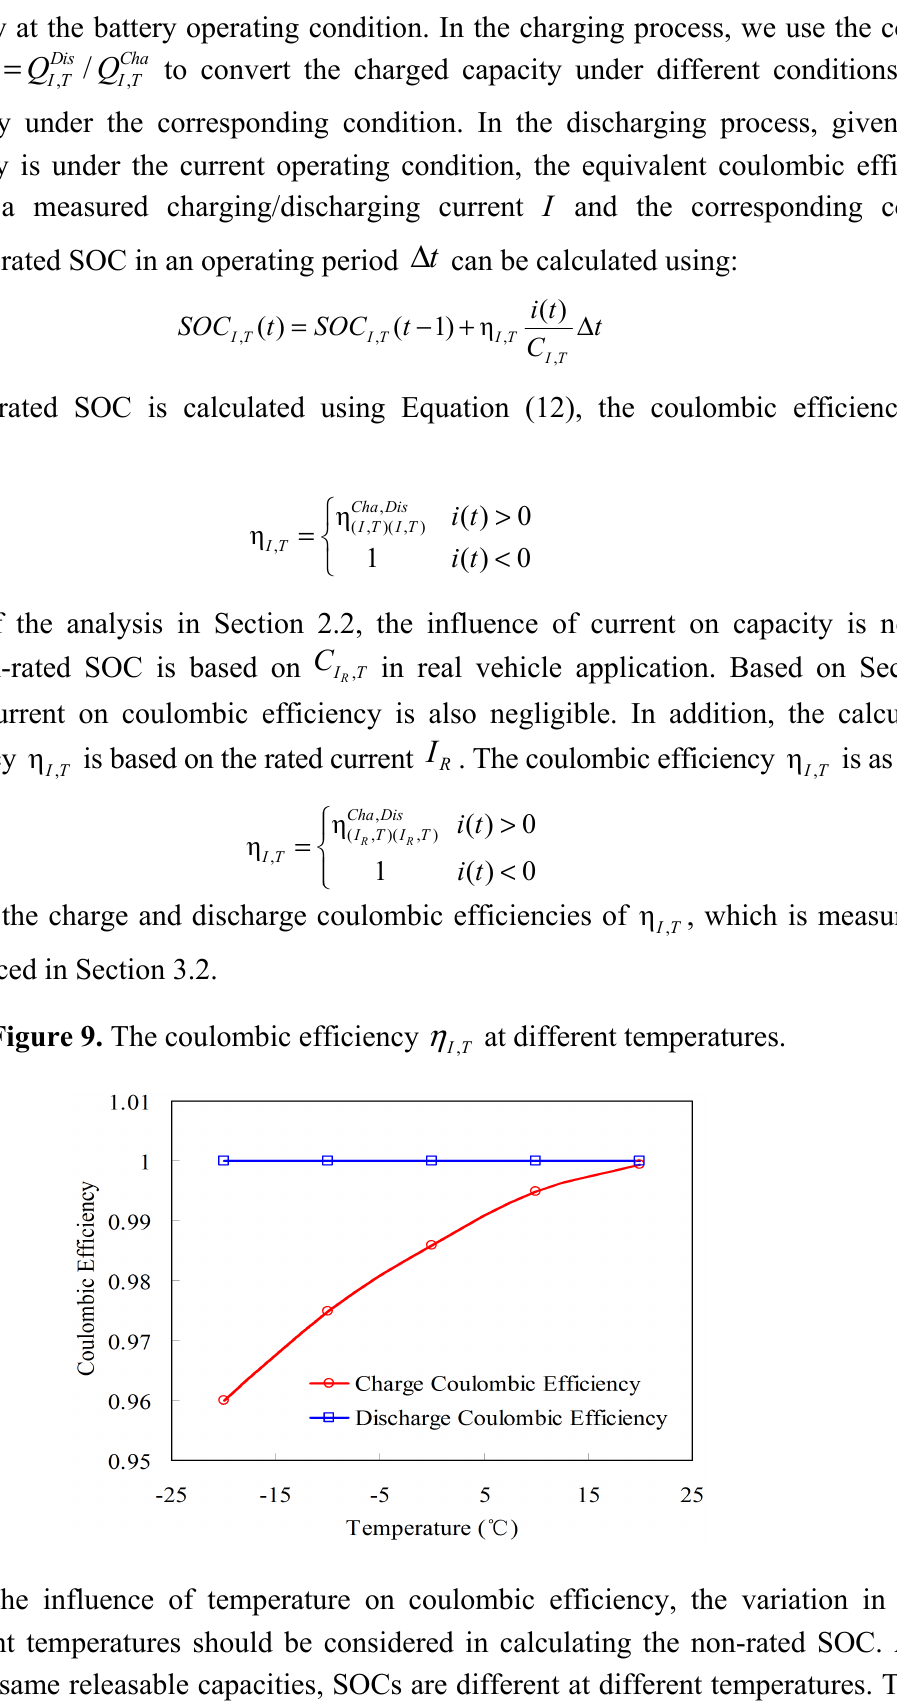
Figure 9. The coulombic efficiency